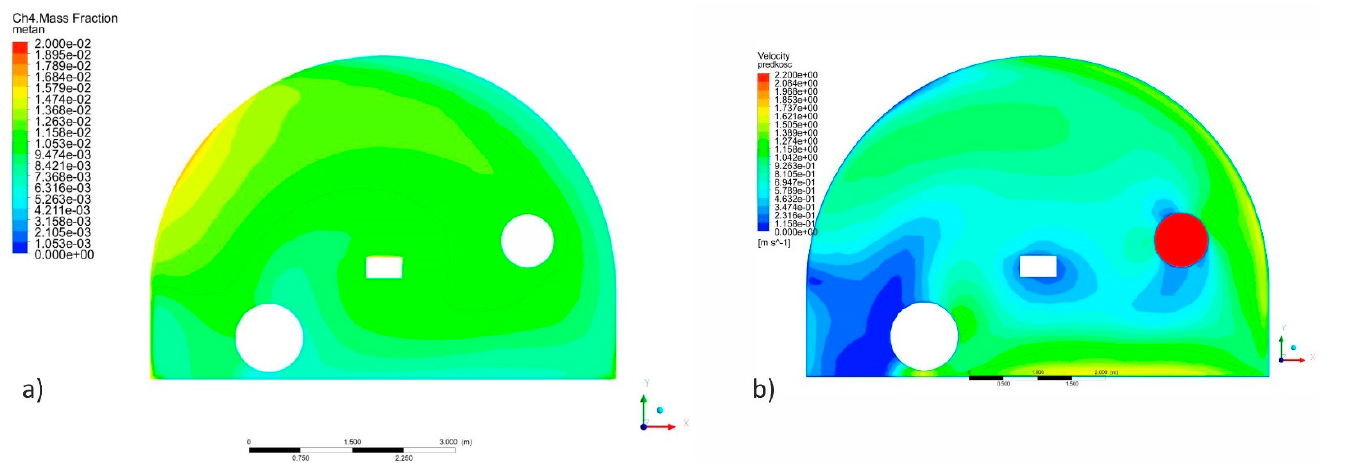
Figure 11. Cross-section of roadway at the distance of 24 m to the face for case L o = 5 m, ( a ) methane concentration field, ( b ) air velocity field